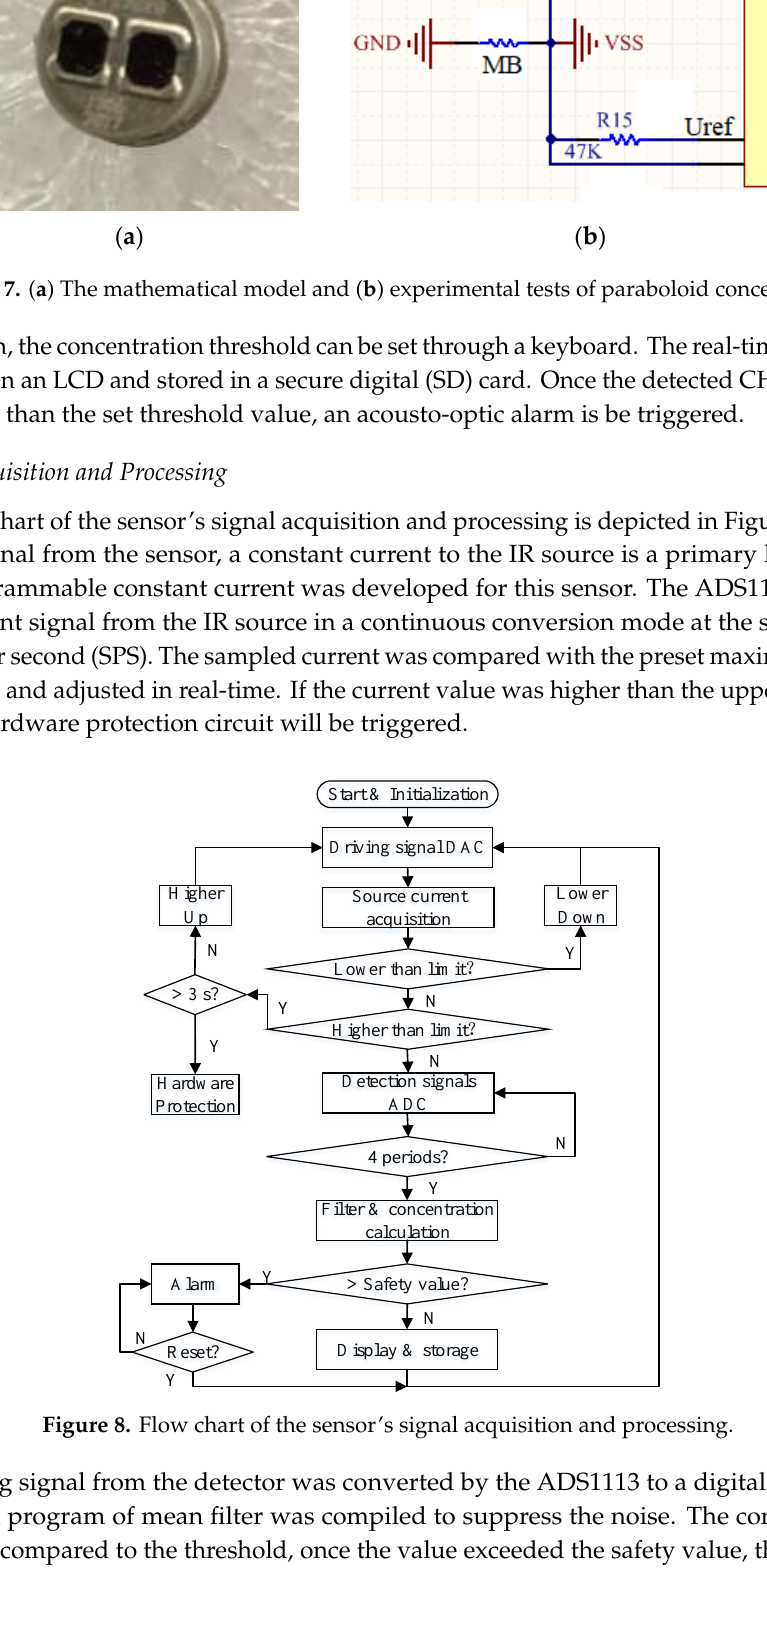
Figure 8. Flow chart of the sensor’s signal acquisition and processing.